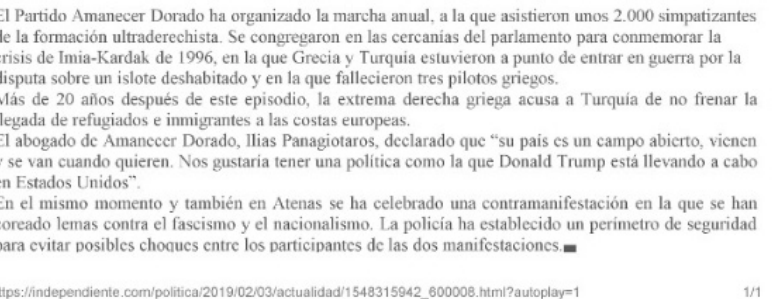
Figure A2. Sample of the news item on the far right in digital newspaper format. Translation: A Greek far-right